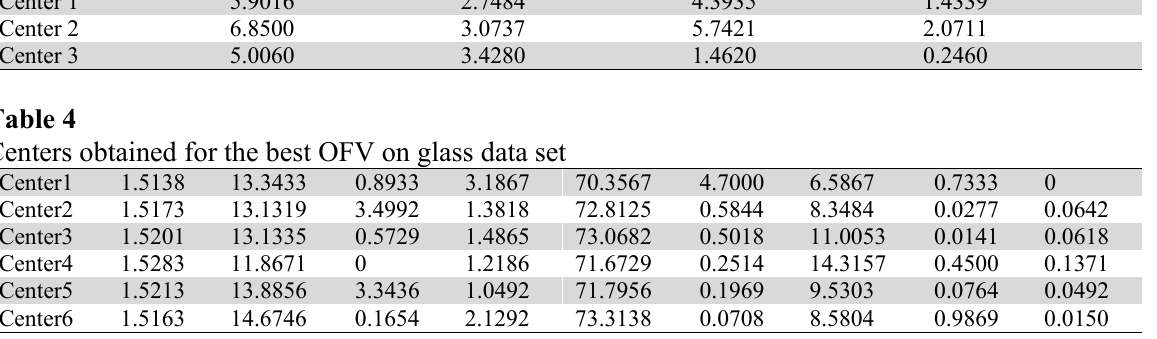
Centers obtained for the best OFV on iris data set Center 1